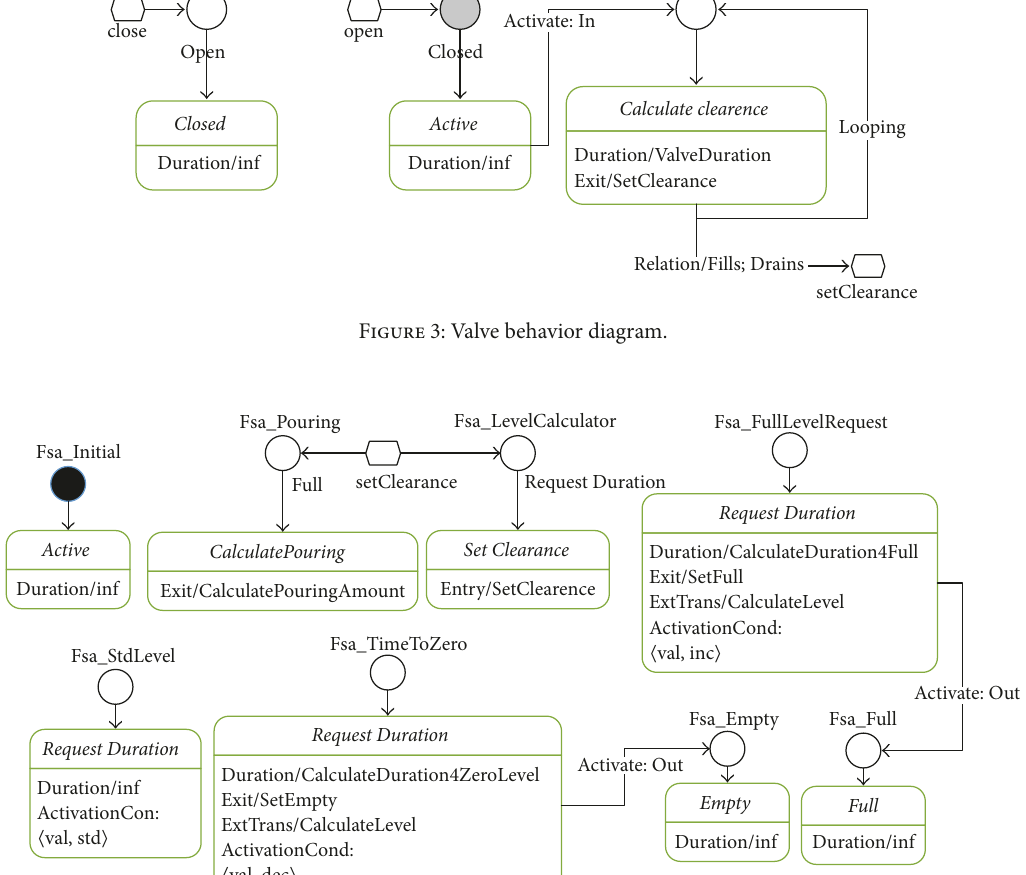
Figure 4: Tub behavior